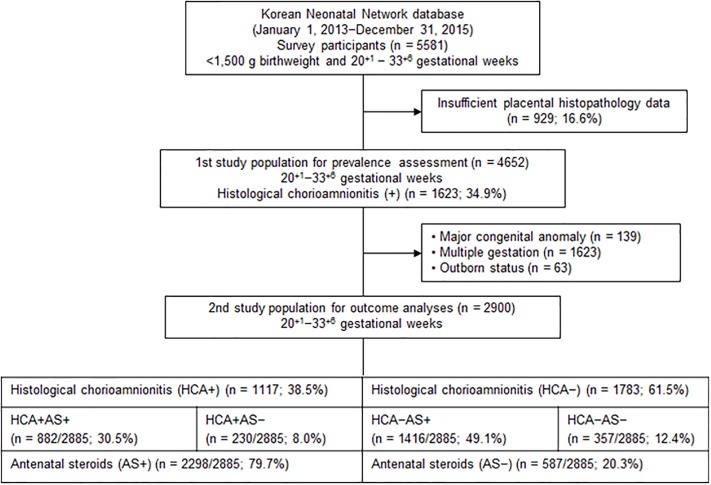
Flow chart of study populations from the Korean Neonatal Network database.